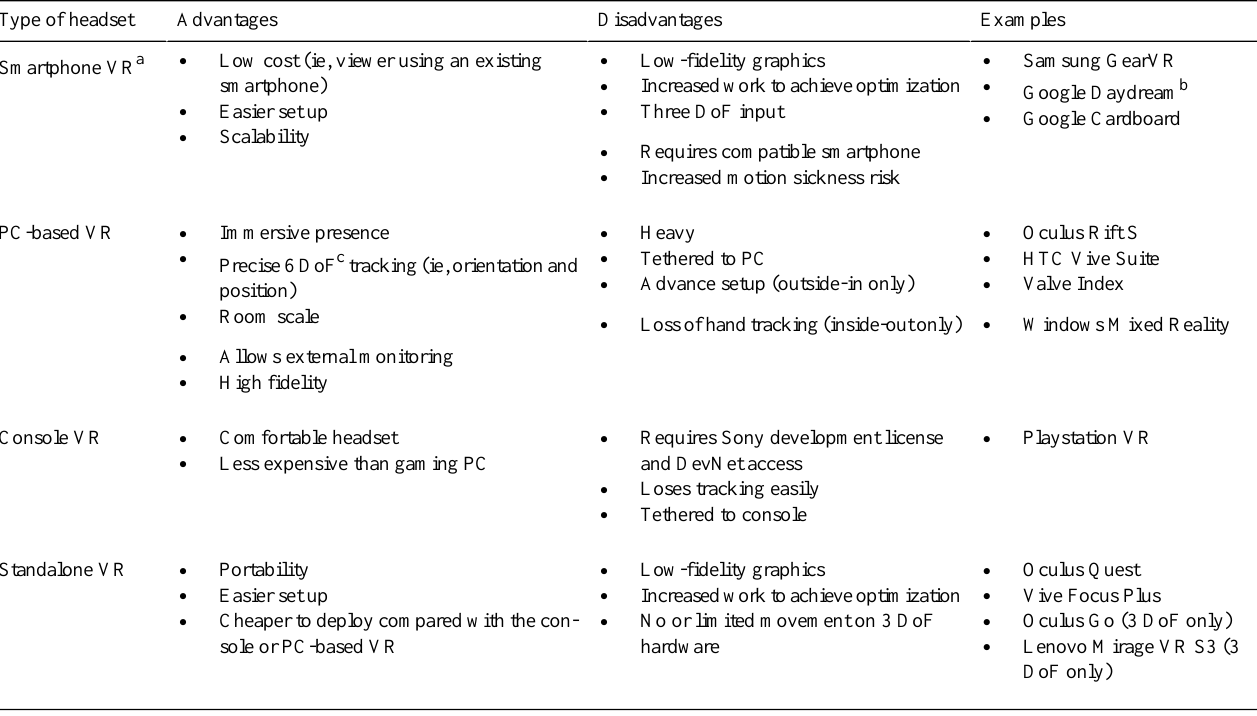
Table 1. Comparison of commercially available virtual reality systems.